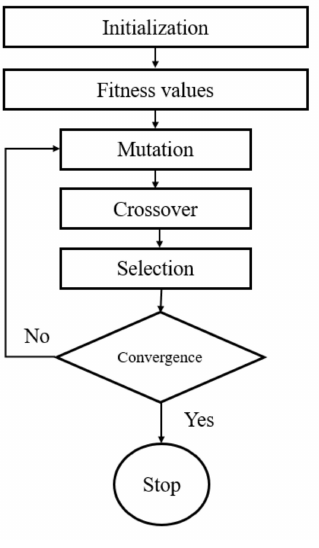
Figure 4. Differential Evolution.